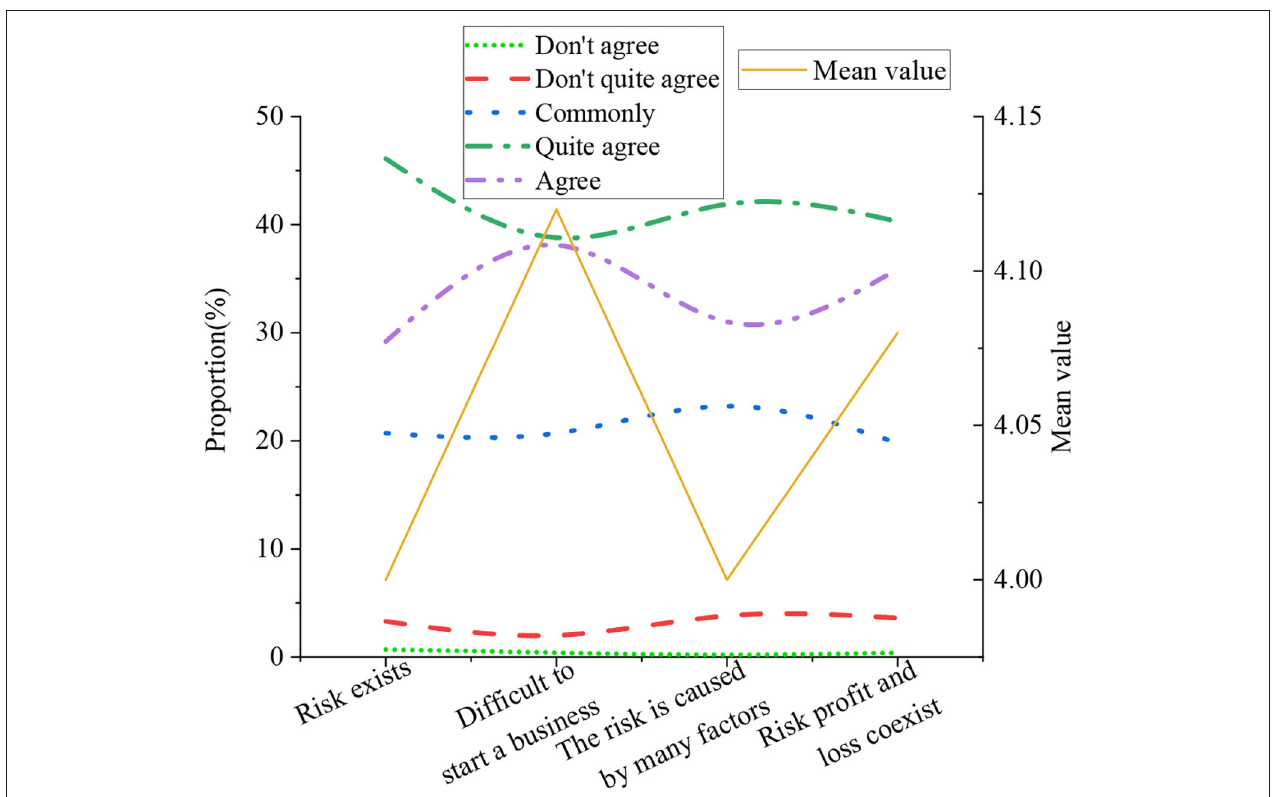
FIGURE 11 | The basic situation of the entrepreneurial risk.